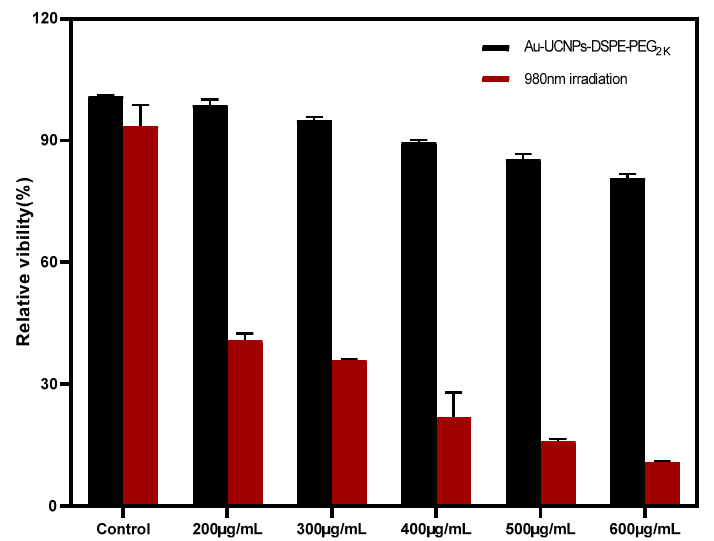
Figure 5. Cytotoxicity of different concentrations of Au-UCNPs-DSPE-PEG 2K before and after irradiation.